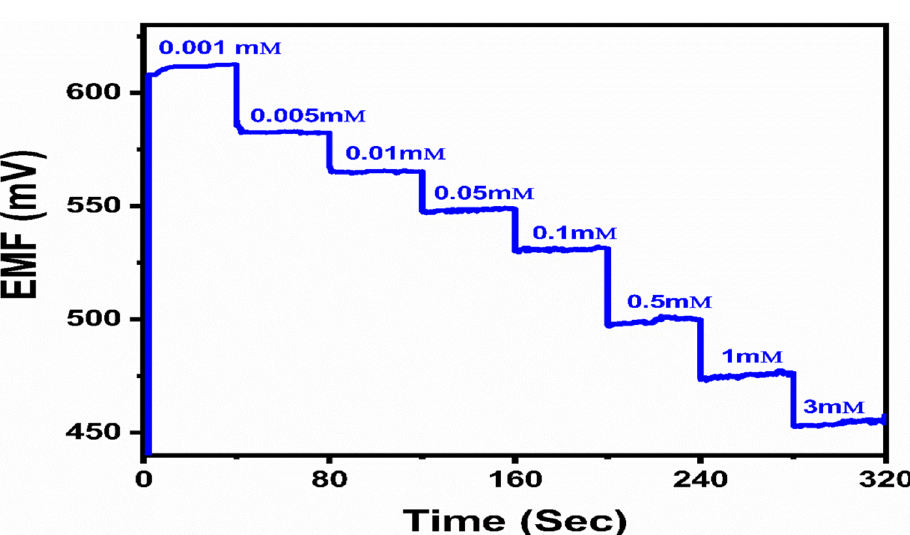
Figure 4. ( a ) Potentiometric response of cholesterol oxidase-immobilized pure Co 3 O 4 platelets and ( b ) cholesterol oxidase-immobilized Co 3 O 4 nanocrystals in 10 mM phosphate buffer solution of pH 7.3.